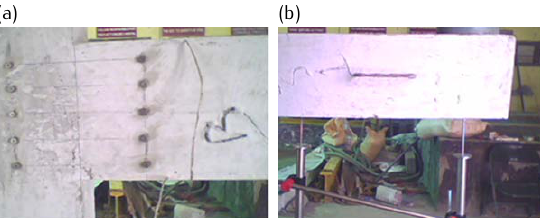
because of the experimental set up limitations, the anchorage failures are not possible to study.